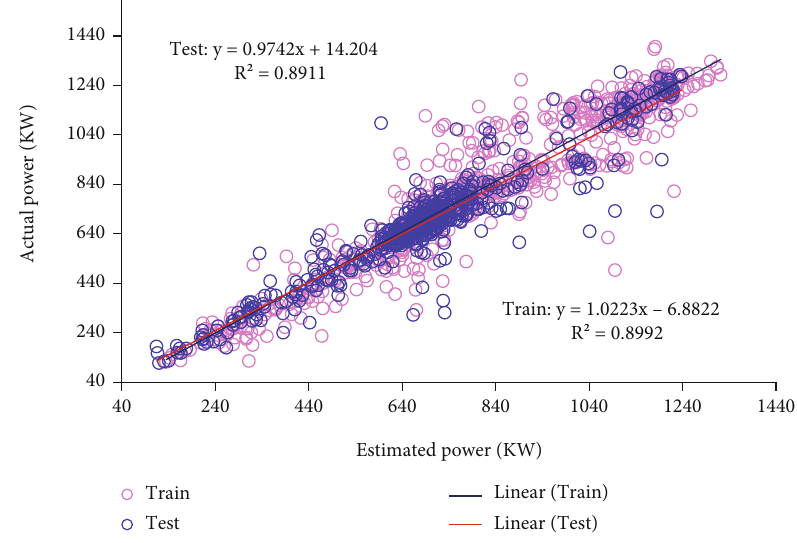
Figure 4: Regression analysis performed on the proposed